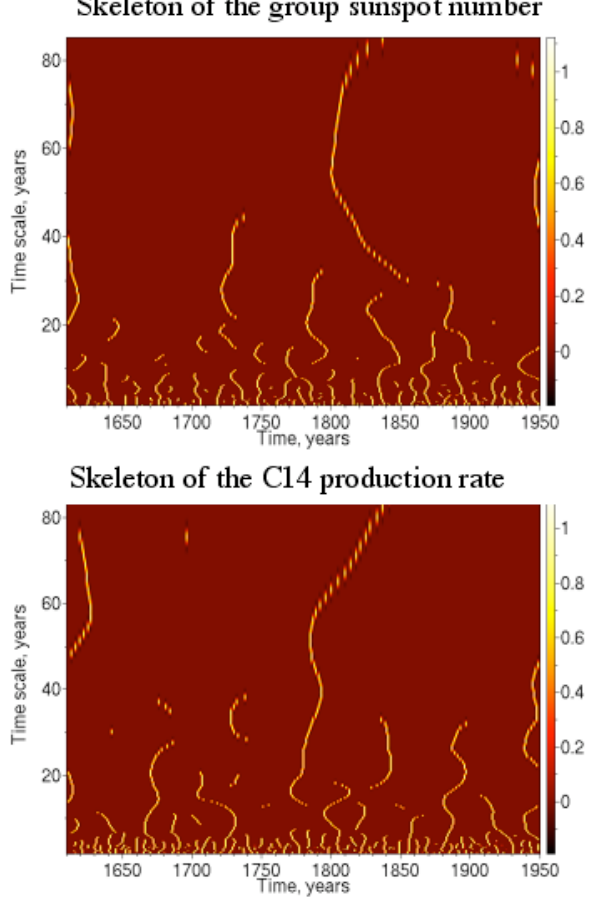
Fig. 8. Skeletons of the group sunspot number and of the 14 C pro- duction rate.